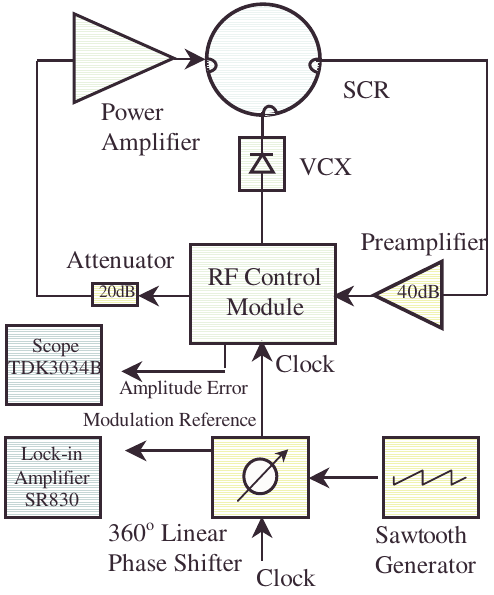
FIG. 5. (Color) Complete experimental setup for using SCR as a beam phase